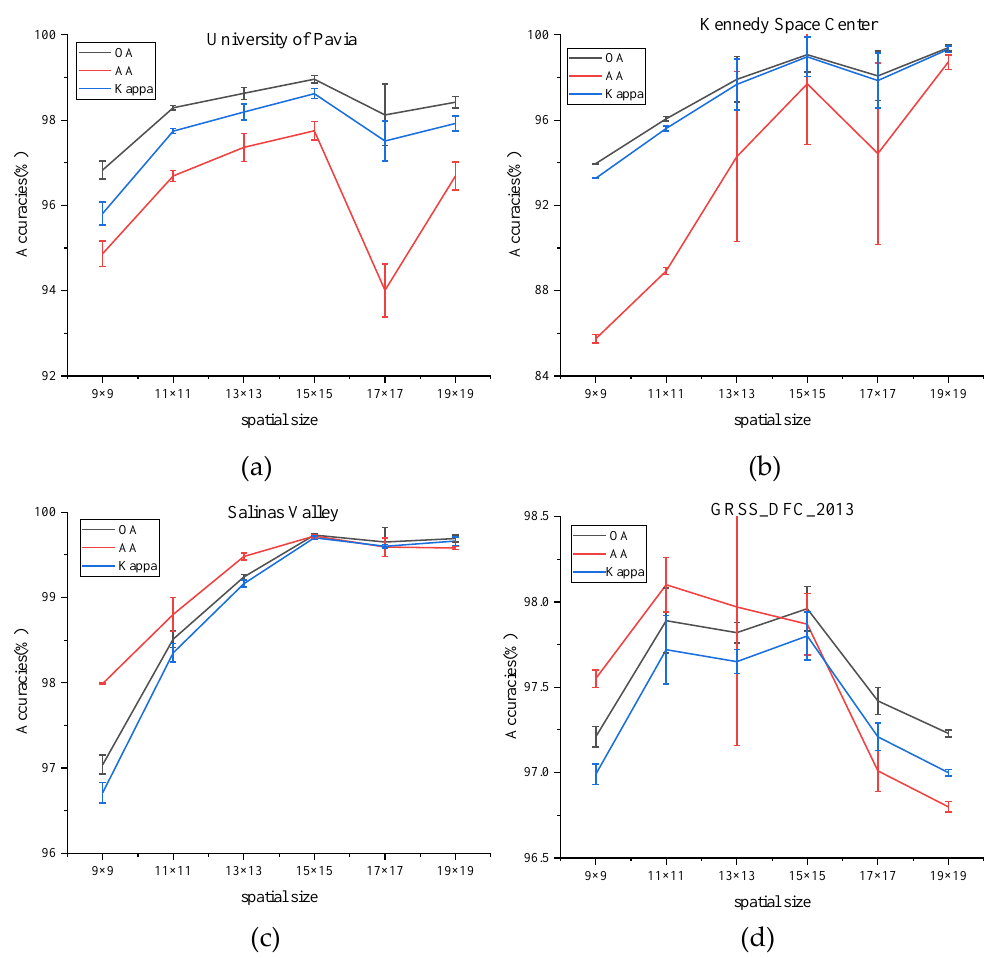
Figure 6. OA, AA, and Kappa accuracies with different spatial size on four datasets. ( a ) Effect of spatial size on University of Pavia dataset, ( b ) Effect of spatial size on Kennedy Space Center dataset, ( c ) Effect of spatial size on Salinas Valley dataset, ( d ) Effect of spatial size on GRSS_DFC_2013 dataset.